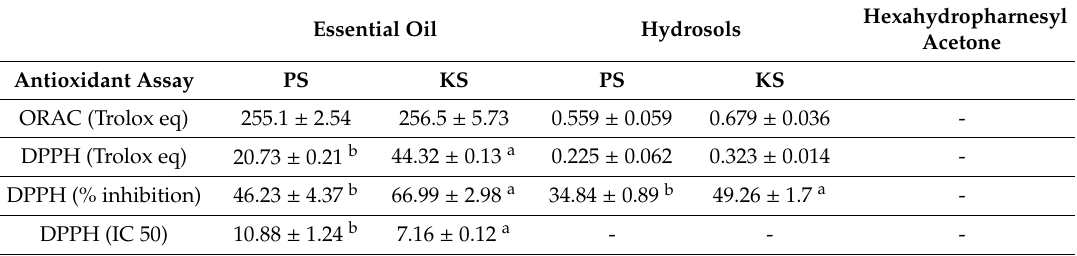
Hexahydropharnesyl Acetone